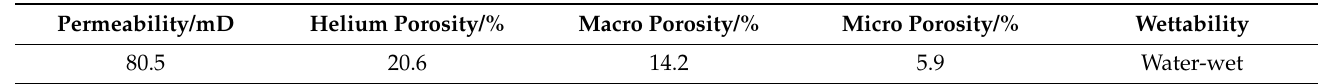
Table 1. Parameters of the sample.